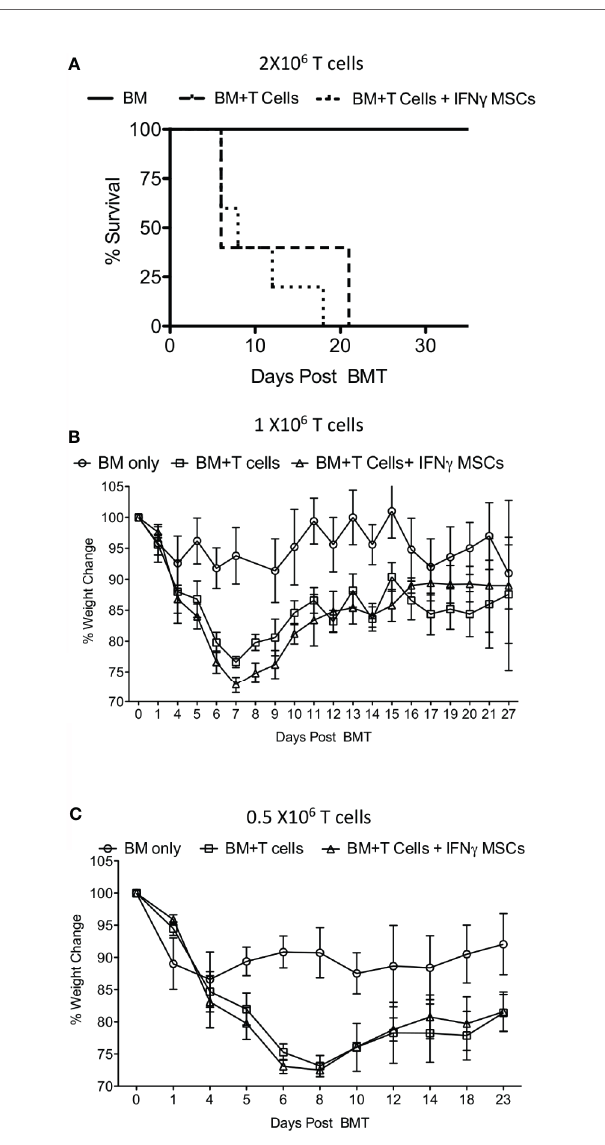
FIGURE 4 | IFN g licensed allogeneic MSCs do not mitigate GvHD from MHC mismatched allogeneic bone marrow transplantation. 4 + 4Gy irradiated Balb/c animals were transplanted with 5X10 6 T cell depleted bone marrow and (A) 2 X10 6 (B) 1 X10 6 and (C) 0.5 X10 6 T cells from C57BL/6 animals. Bone marrow alone group were transplanted only with 5X10 6 T cell depleted bone marrow from C57BL/6 animals without splenic T cells. IFN g licensed C57BL/6 MSCs (20ng/ml for 48 hours) were injected intraperitoneally into the Balb/c animals transplanted with C57BL/6 bone marrow and T cells on day 2 and day 8 post transplantation. For the experiments with 0.5X10 6 T cells, IFN g licensed C57BL/6 MSCs were given on days 1, 3, 5 and 8. Body weight and survival was monitored longitudinally. Each of the experiments with 2 X10 6 1 X10 6 and 0.5 X10 6 T cell and BM transplantation and MSC infusion were done